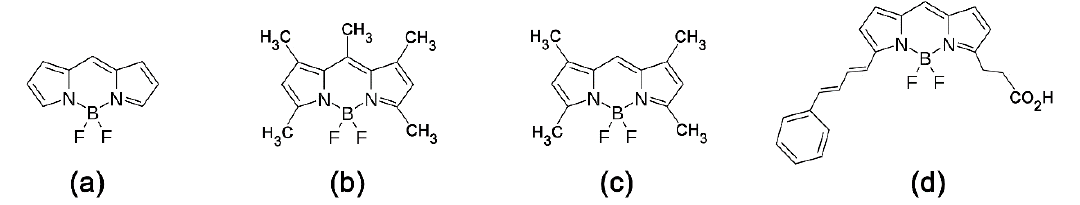
Figure 5. Structures of some BODIPY derivatives. ( a ) BODIPY core structure; ( b ) BODIPY 493/503; ( c ) BODIPY505/515; ( d ) BODIPY581/591.